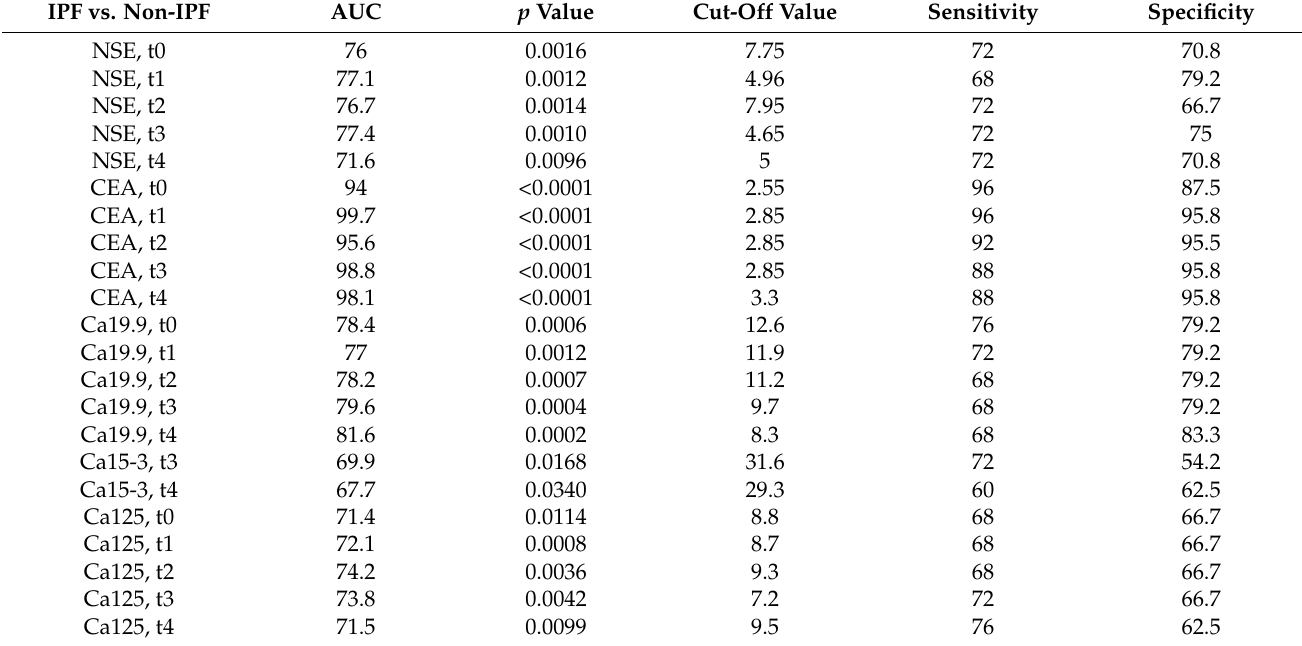
Table 2. Receiver operating characteristic (ROC) curve analysis between IPF and non-IPF patients according to oncomarker concentrations at each sampling time. Abbreviations: t0, baseline; t1, 6 months; t2, 12 months; t3, 18 months; t4, 24 months. IPF vs.